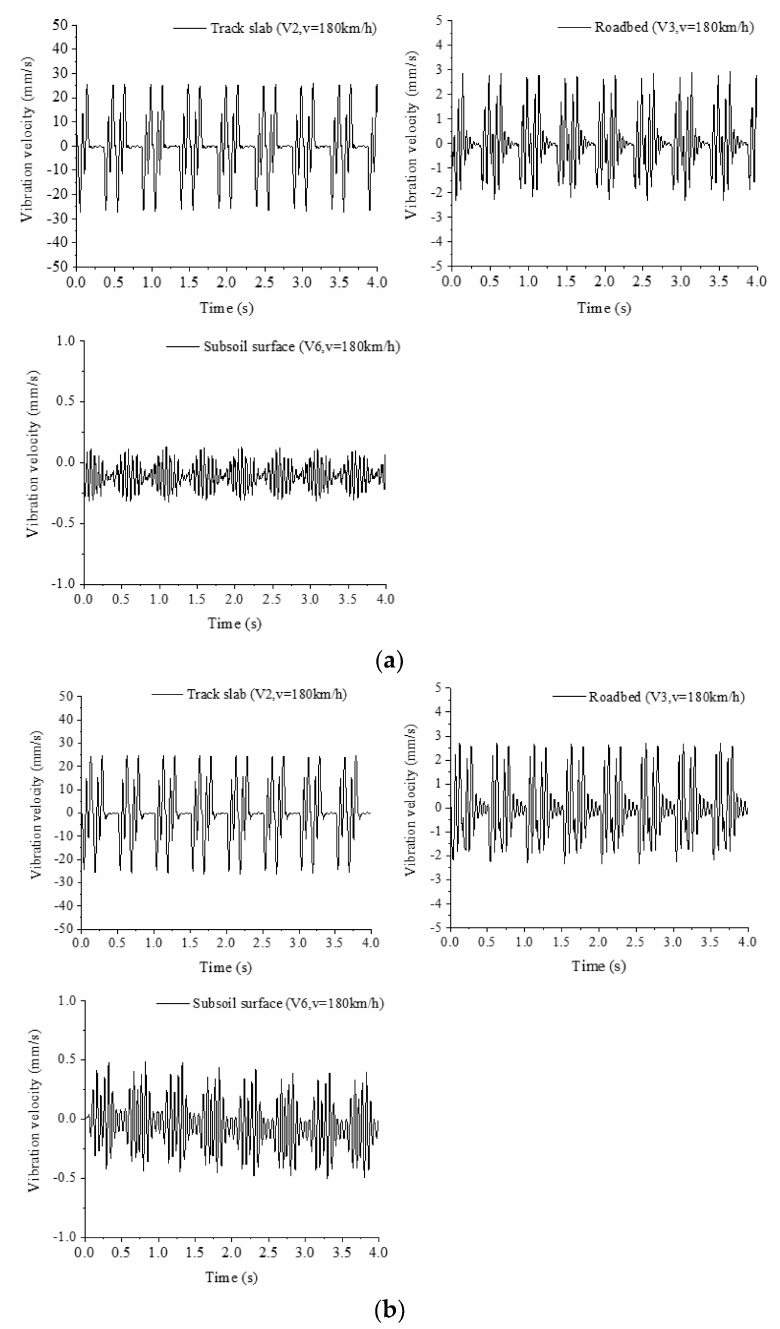
Figure 5. Time histories of vibration velocity at track slab V2, roadbed V3, and subsoil surface